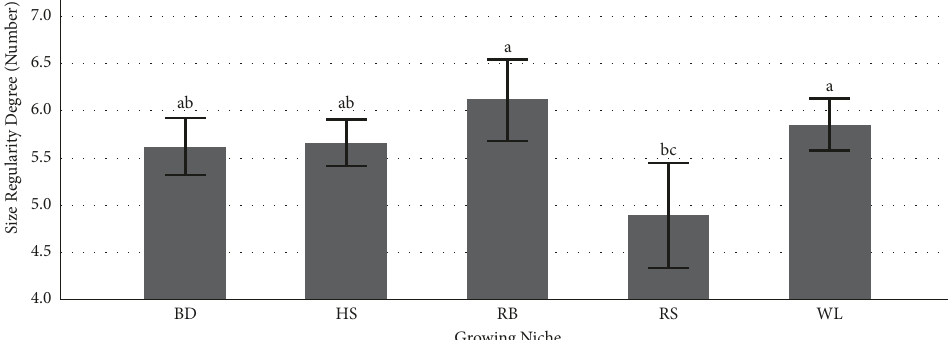
Figure 7: Size regularity degree of bamboo culms (BD � boundary; HS � homestead; RB � river bank; RS � roadside; WL � woodlot plantation niches; values with different letters across bars are significantly different (at α <